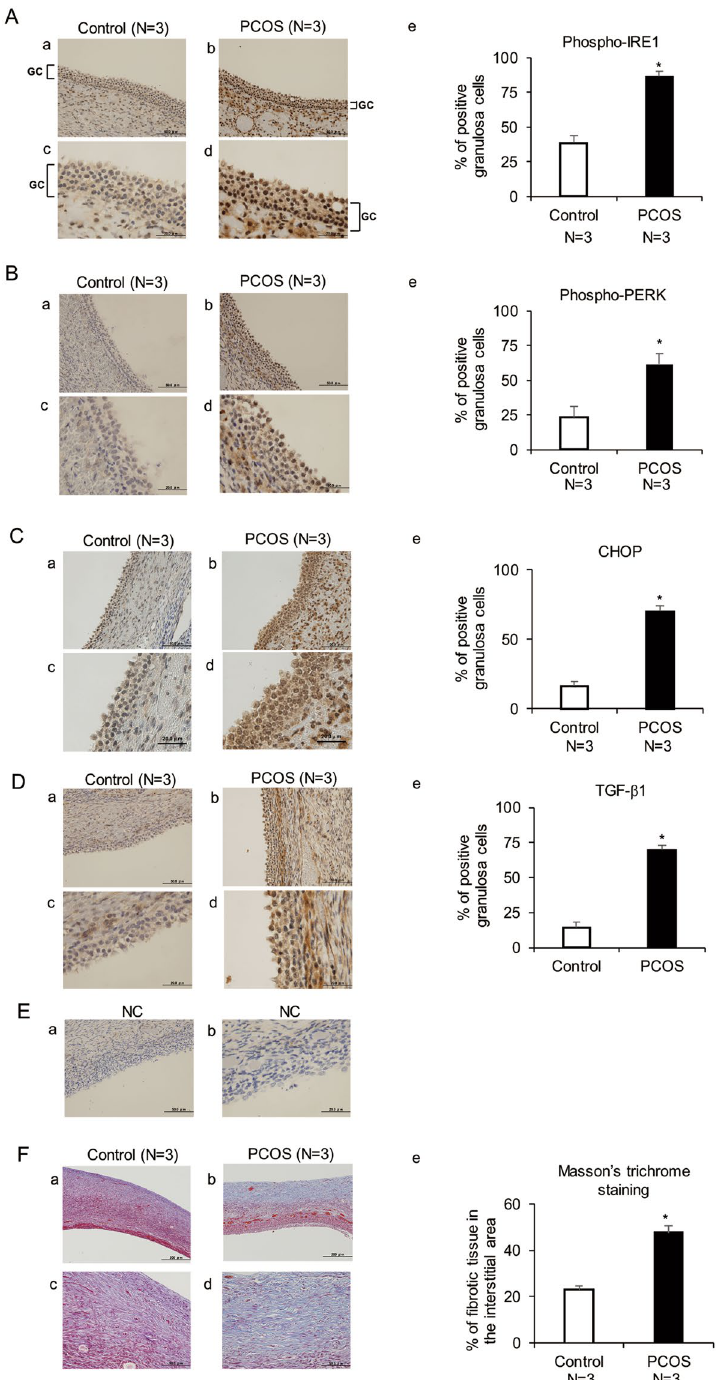
Figure 2. Phospho-IRE1, phospho-PERK, CHOP, and TGF- β 1 protein expression levels and the area of fibrotic tissue in the ovaries of control and PCOS patients. Immunohistochemical analysis was performed on the ovaries of 3 PCOS and 3 control patients. ( A – D ) Cross-sections of ovaries were stained with an anti-phospho-IRE1, anti-phospho-PERK, anti-CHOP, or anti-TGF- β 1 antibody, counterstained with hematoxylin. ( E ) Controls for background level stained with isotype IgG and hematoxylin. ( F ) Cross-sections of ovaries were stained with Masson’s trichrome stain. Fibrotic tissue was stained blue. ( A – D , F ) (a–d) show the representative sections. Lower panels (c,d) show highly magnified views corresponding to (a,b). (e) show the quantitative analysis of ( A – D ) immunohistochemical staining and ( F ) Masson’s trichrome staining. ( E ) A right panel (b) shows a highly magnified view corresponding to a left panel (a). The scale bars in ( A – D ) (a,b) and ( E ) (a) indicate 50 μ m, while those in ( A – D ) (c,d) and ( E ) (b) indicate 20 μ m. The scale bars in ( F ) (a,b) and ( F ) (c,d) indicate 200 μ m and 50 μ m, respectively. * p < 0.05. GC, granulosa cell layer; NC, negative